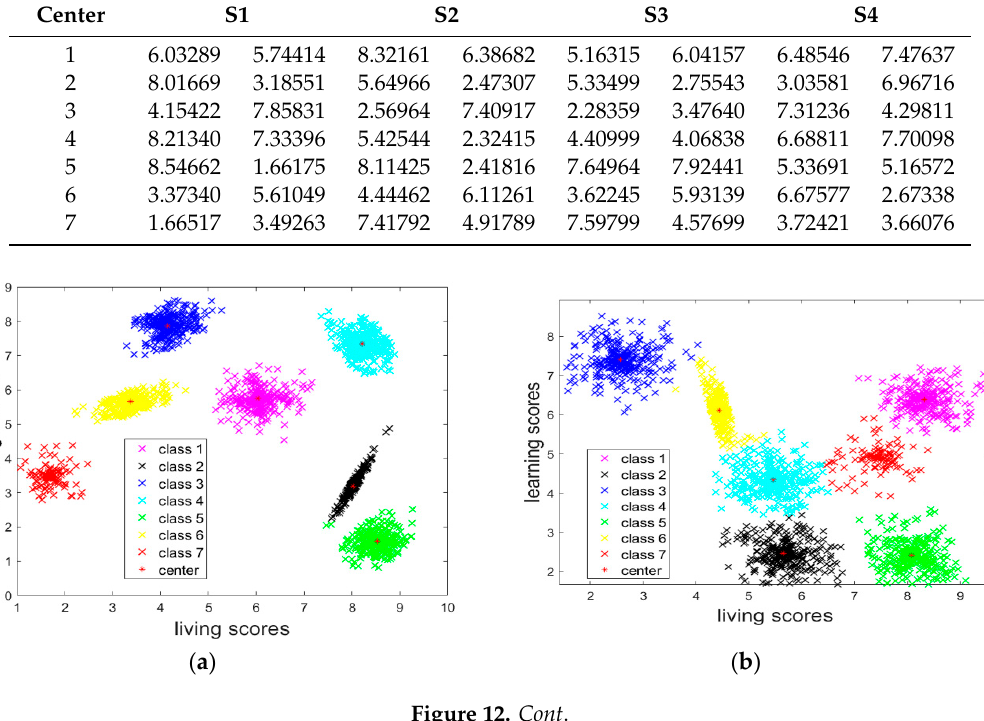
Figure 11. γ value. Table 4. The cluster centers of K-Means and clustering by fast search and find of density peaks (K-CFSFDP).